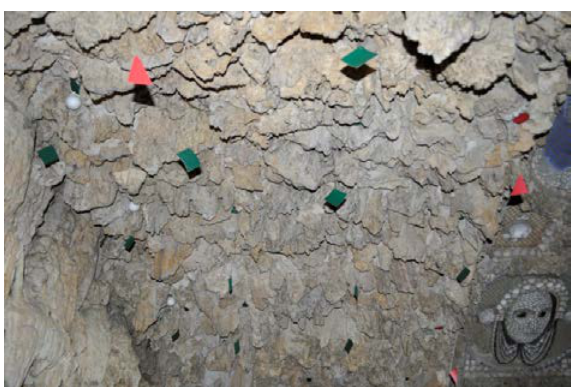
Figure 5. Paper flags used to highlight the nozzles in the vault.